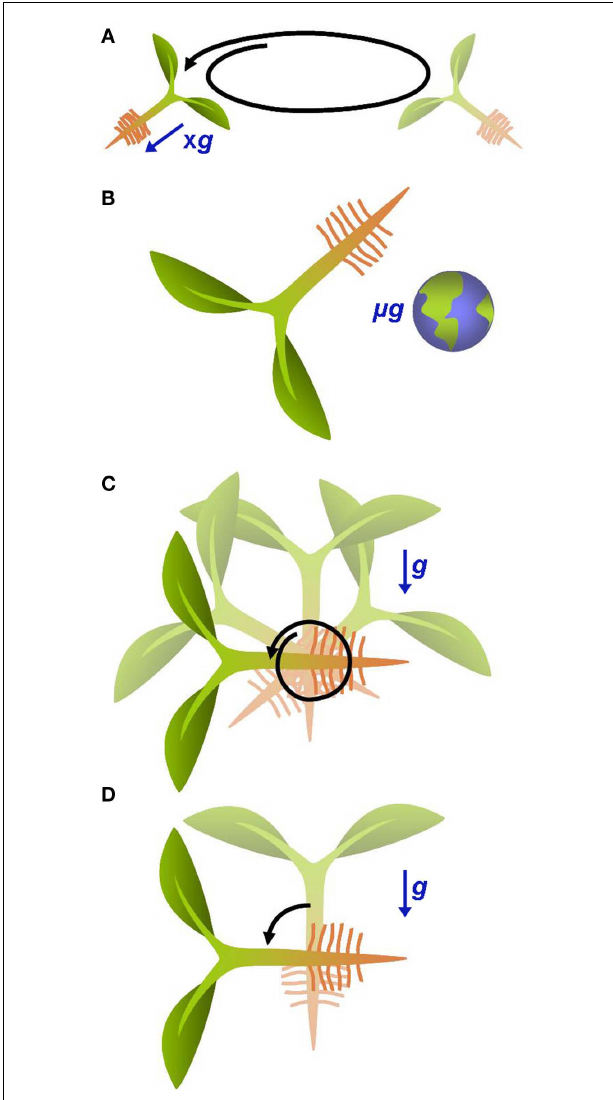
FIGURE 1 | General principles used in gravity research. (A) Centrifugation increases the magnitude of the g -vector resulting in a hyper-gravity stimulus. (B) True micro-gravity conditions can be obtained on orbital platforms or during the free-fall phases of sounding rockets and parabolic flights. (C) Omnilateral micro-gravity is achieved by continuously rotating the specimen, either in 2D or 3D.This does not change the magnitude of the g -force, but it eliminates the effect of the unidirectional stimulus caused by the g -vector. (D) Turning a specimen changes the orientation of the g -vector relative to the